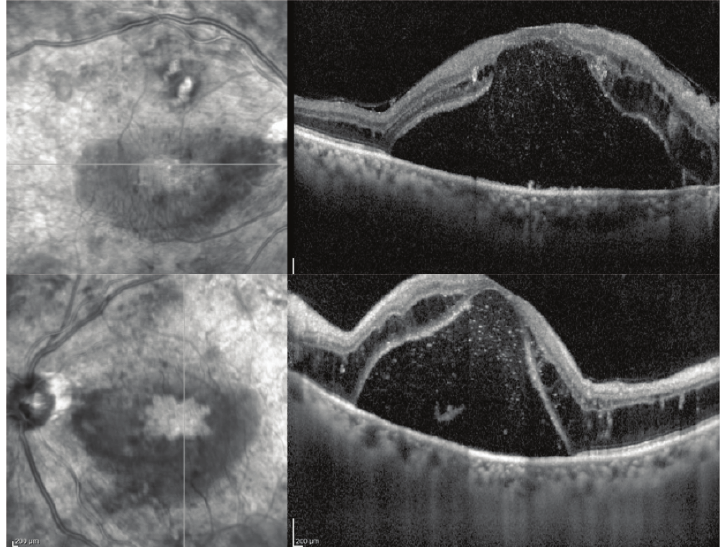
Figure 4. Optical coherence tomography of the right (above) and left (below) eyes showing worsening of cystoid macular edema and serous macular detachment despite treatment.